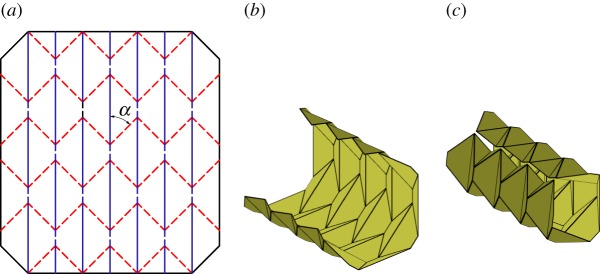
Chicken wire tessellation. Mountain folds are indicated by solid lines and valley folds by dashed lines. Fold lines of the same colour have the same fold angle. (a) Fold pattern, (b) partially folded position, and (c) pre-interference position.